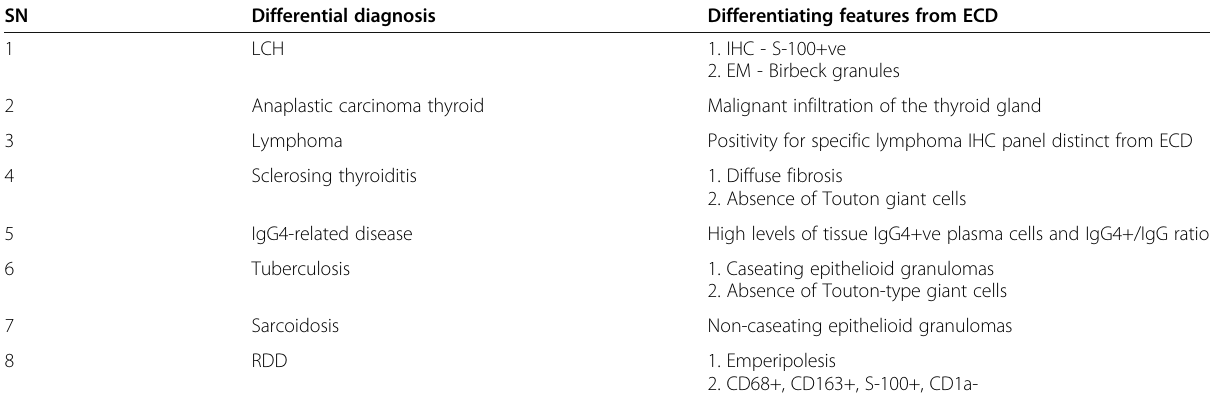
Table 1 Differential diagnosis for the neck swelling in the present case